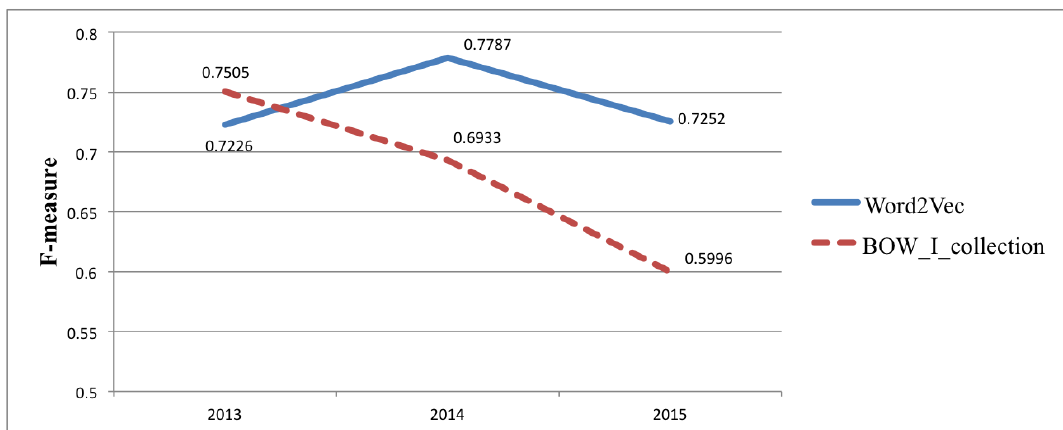
Figure 3. Comparison of the use of model Word2Vec word vectors as features and a lexicon based on a bag-of-words from the